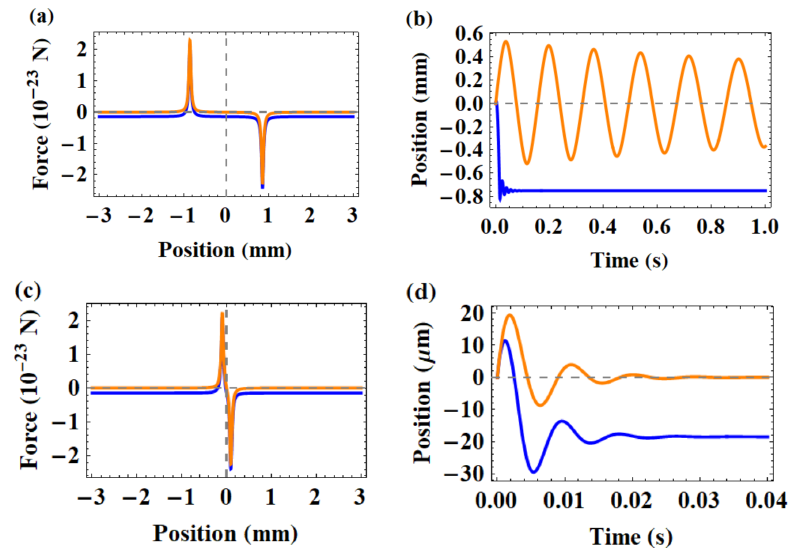
Figure 2. Numerical simulation of the motion of a single 88 Sr atom in the vertical direction driven by mean force in the single-frequency, red MOT. Blue curves correspond to the case on the ground, and orange curves to the case in a µ -gE (microgravity environments). ( a , c ) show the mean force of a rest atom depending on location. ( b , d ) show the evolution of the atom position. ( a ) and ( b ) show laser detuning of ∆ = − 2 π × 1.8 MHz, while ( c ) and ( d ) show ∆ = − 2 π × 200